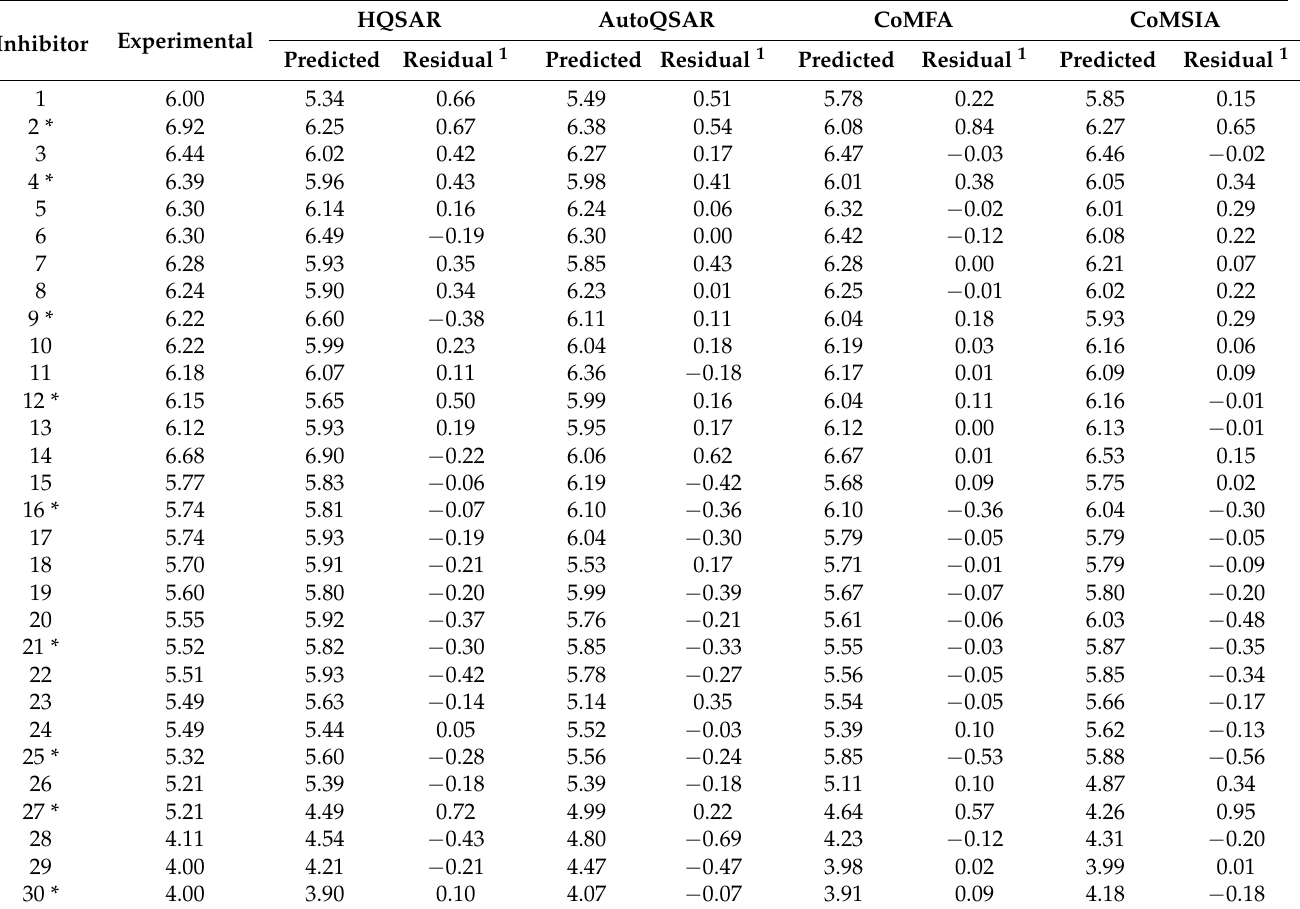
Table 4. Experimental and predicted pIC 50 values for the final HQSAR, AutoQSAR, comparative molecular field analysis (CoMFA), and comparative molecular similarity indices analysis (CoMSIA) models. HQSAR AutoQSAR CoMFA CoMSIA Inhibitor Experimental Predicted Residual 1 Predicted Residual 1 Predicted Residual 1 Predicted Residual 1